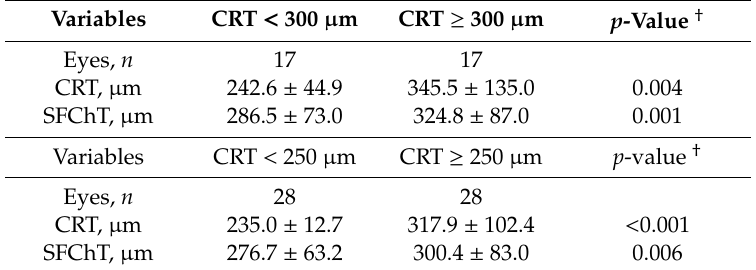
Table 6. Comparison of the central retinal thicknesses and subfoveal choroidal thicknesses of eyes with and without diabetic macular edema in patients with unilateral diabetic macular edema. Variables CRT < 300 µ m CRT ≥ 300 µ m p -Value † Eyes, n 17 CRT, µ m 242.6 ±